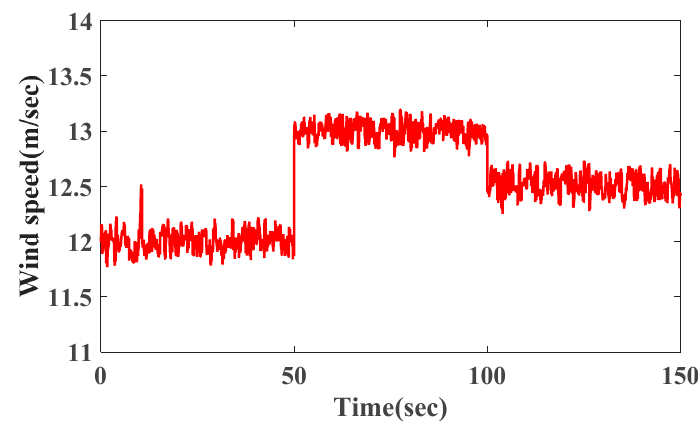
Figure 17. Wind speed variations with sudden disturbance.